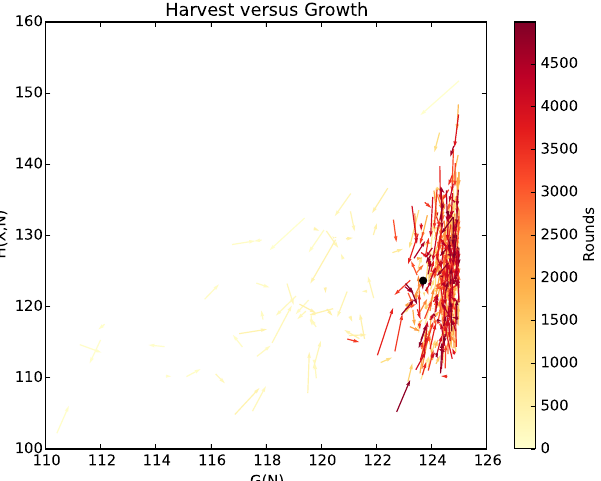
Figure 7. A phase graph plotting harvest versus growth demonstrates how the population as a whole harvests in a manner that moves the resource level towards E optinal (the black dot). After the initial learning phase (brighter arrows), agents settle oscillating around the optimal resource level (dark arrows), indicating they invest efforts described in Fig. 4.